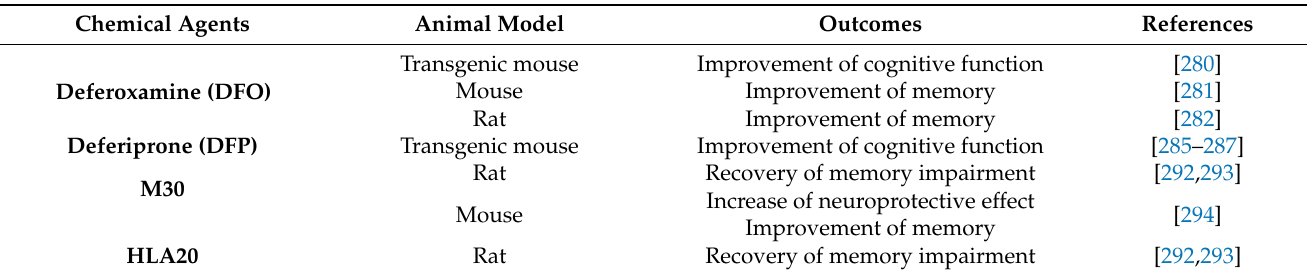
Table 3. Recent animal studies conducted with Fe-targeting chemical agents. Results of in vivo experiments performed with deferoxamine ( DFO ), deferiprone ( DFP ), M30 , and HLA20 are